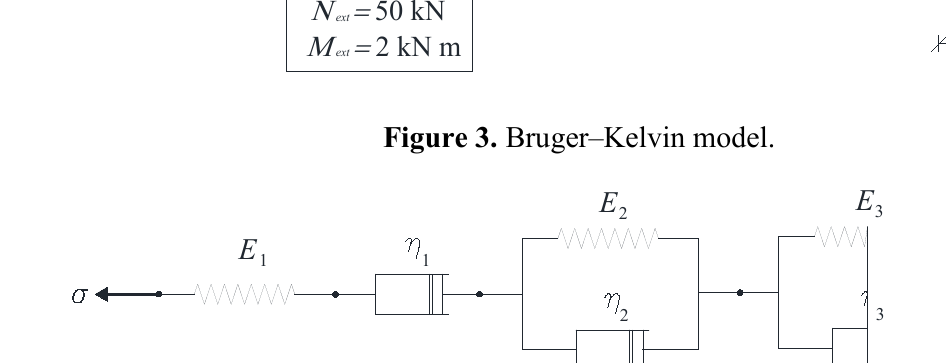
Figure 3. Bruger–Kelvin